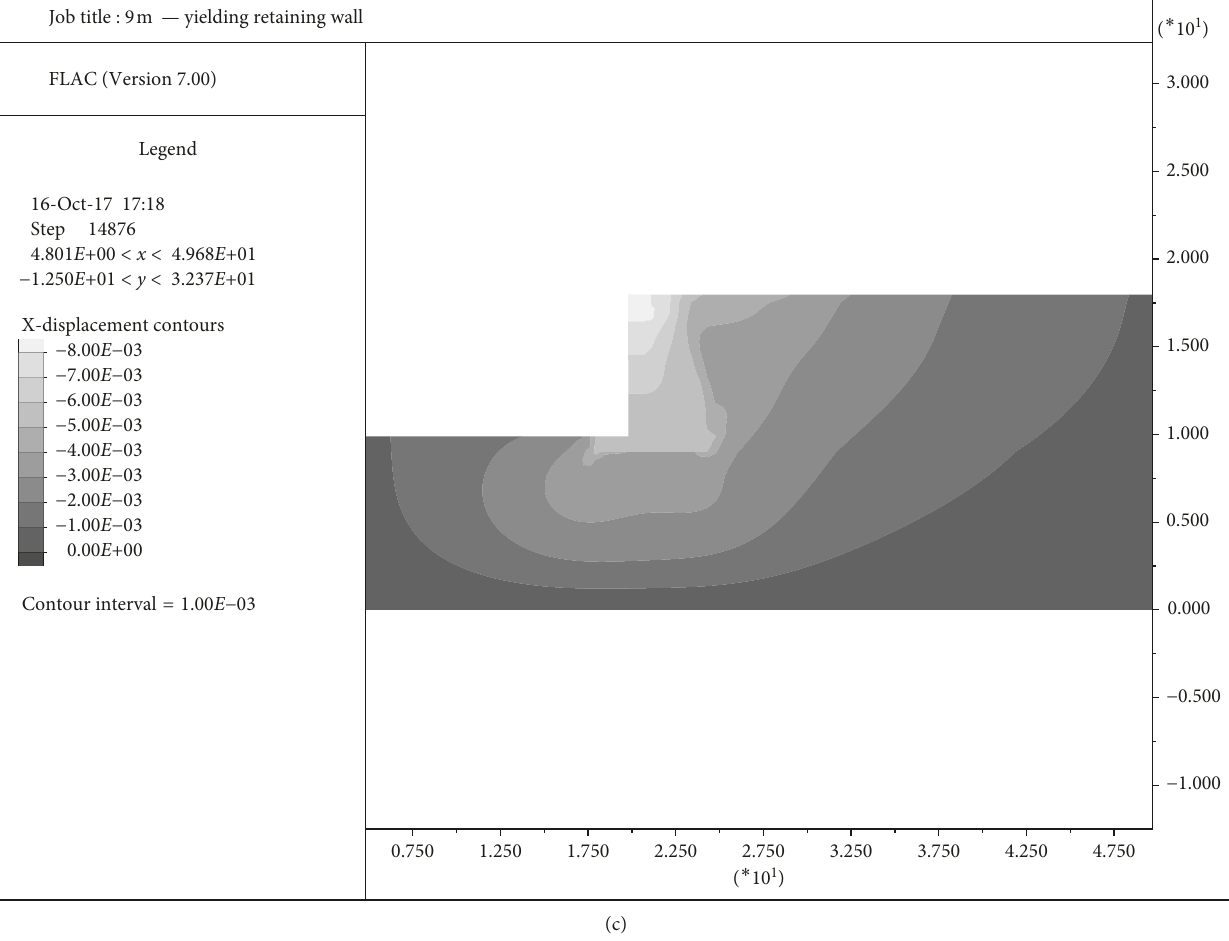
3m, (b) H 6 m, and (c) H 9 (cid:31) (cid:31) (cid:31)